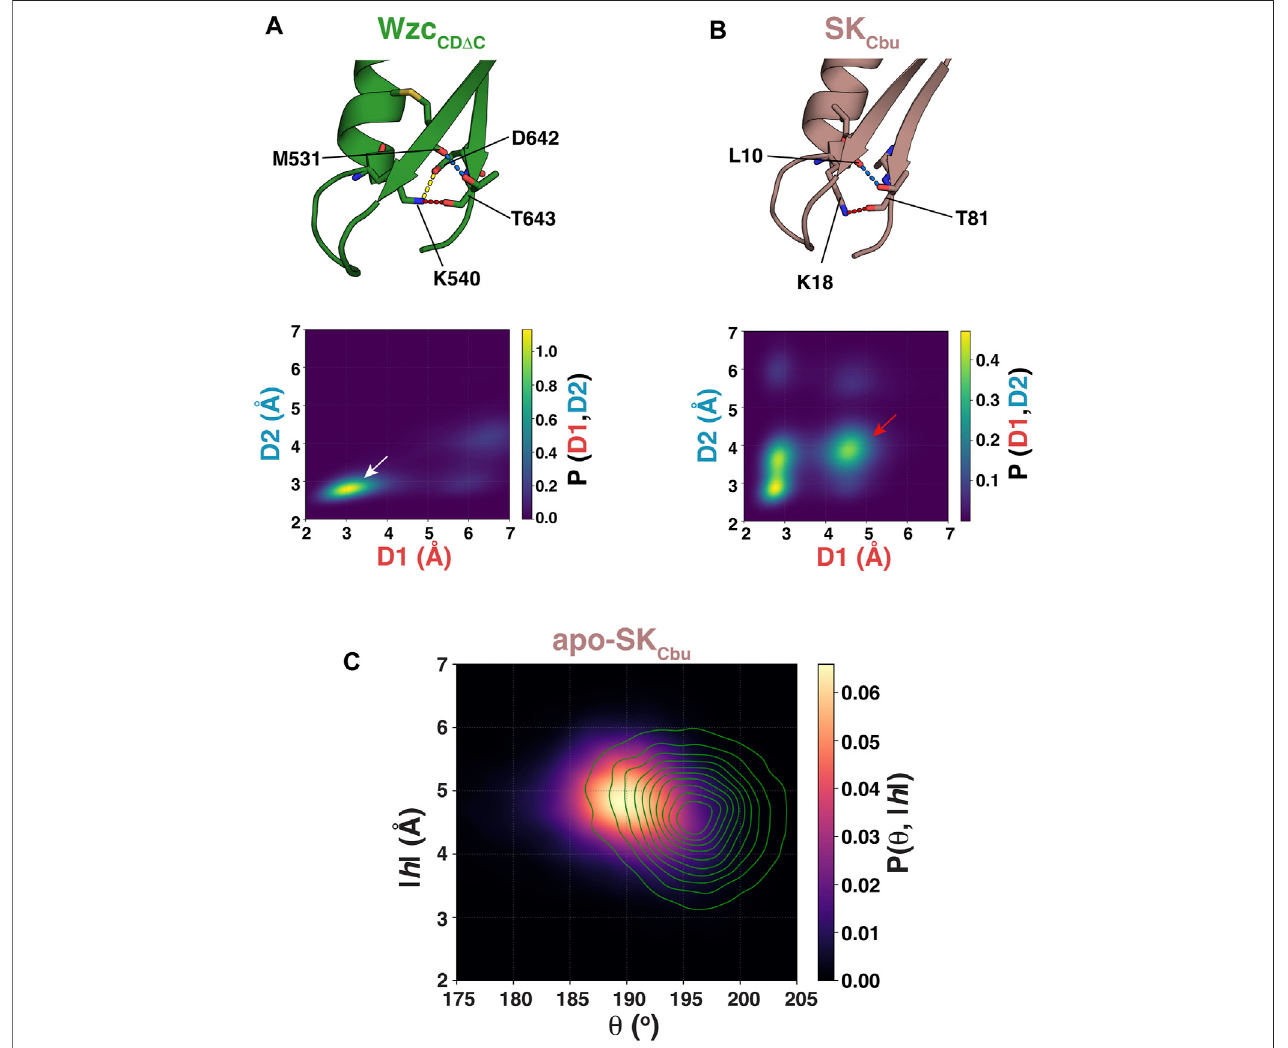
FIGURE 3 | (A) Interactions of the Walker-A K540 with the Walker-B D642 (yellow dashed line), of K540 with T643 (red dashed line), and of T643 with M531 (blue dashed line)forWzc CD Δ C intheOSareshown. (B) InteractionsoftheWalker-A K18withWalker-BT81(reddashed line)andofT81withL10(bluedashed line)forSK Cbu in the WOS are shown. The lower panels, in each case, show the structural ensembles of unliganded Wzc CD Δ C and SK Cbu projected onto the 2-dimensional space spanned by the {K540-T643 (D1: K540,N ξ − T643,O), T643-M531 (D2: T643,O γ 1 − M531,O)} and {K18-T81 (D1: K18,N ξ − T81,O), T81-L10 (D2: T81,O γ 1 − L10,O)} distances, respectively. (C) The structural ensemble ofunligandedSK Cbu is projected onto θ -| h |space and plotted using kerneldensity estimation. Also shown asgreen contours in the corresponding projection of the unliganded SK Mtu